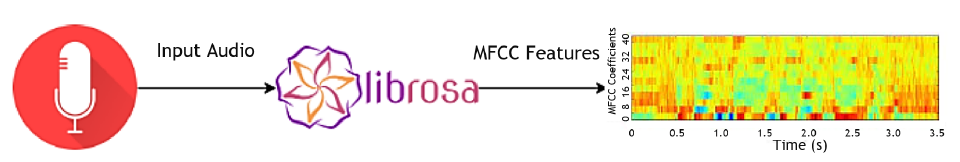
Figure 3. MFCC audio feature